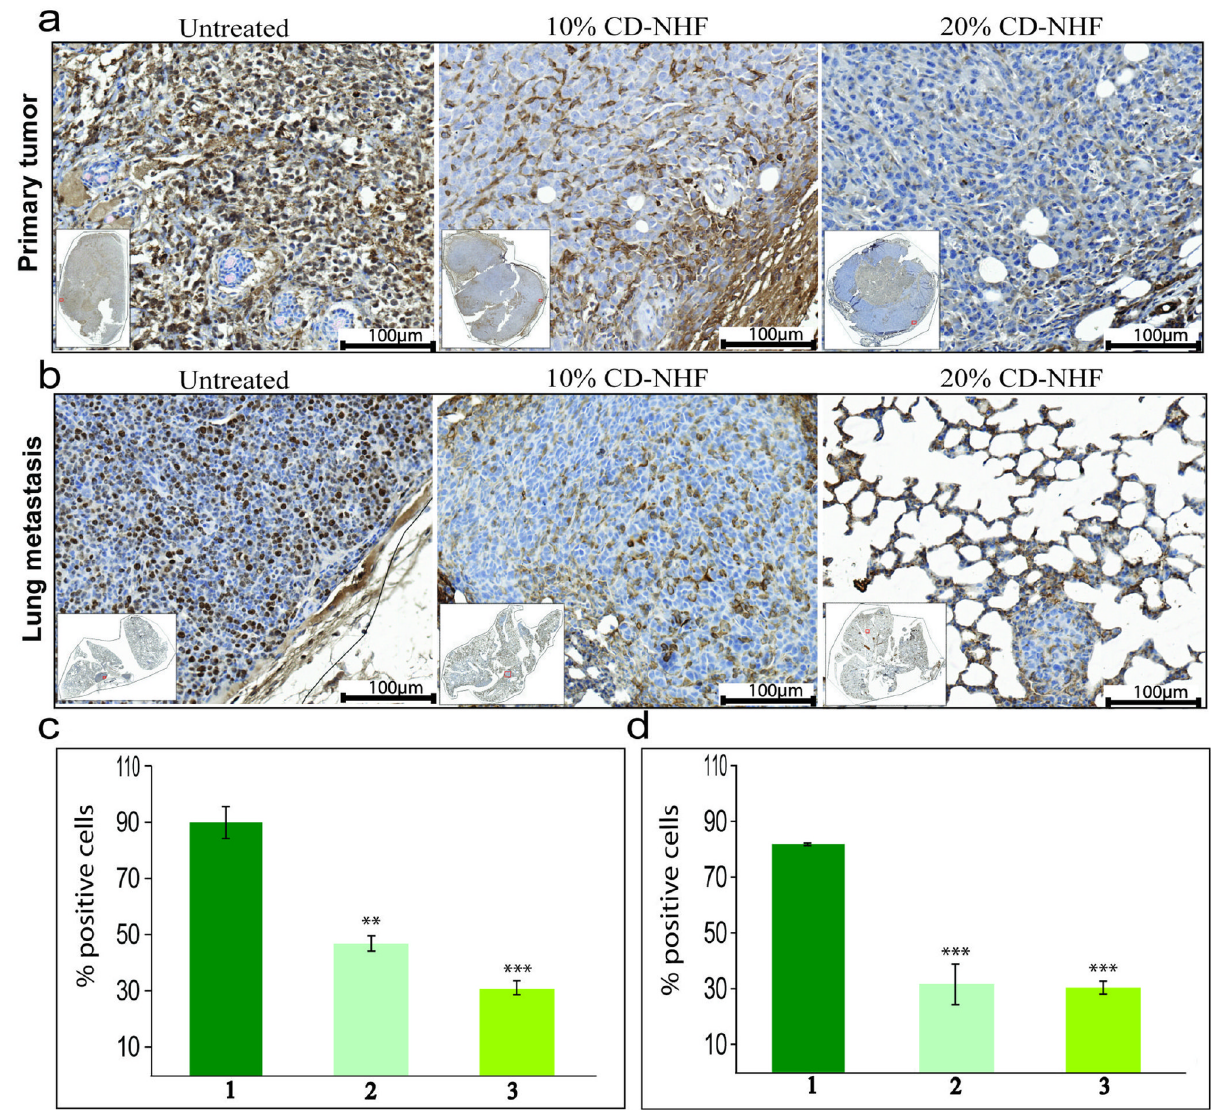
Figure 7. HSP90 expression. A . Primary tumours. 1. untreated; 2. treated with 10% CD-NHF; 3. treated with 20% CD-NHF. B . Lung metastasis. 1. untreated; 2. treated with 10% CD-NHF; 3. treated with 20% CD-NHF; C . Quantification of HSP level in Primary tumour; D . Quantification of HSP level in Lung metastasis. **p < 0.005, ***p < 0.0005 Pictures acquired at